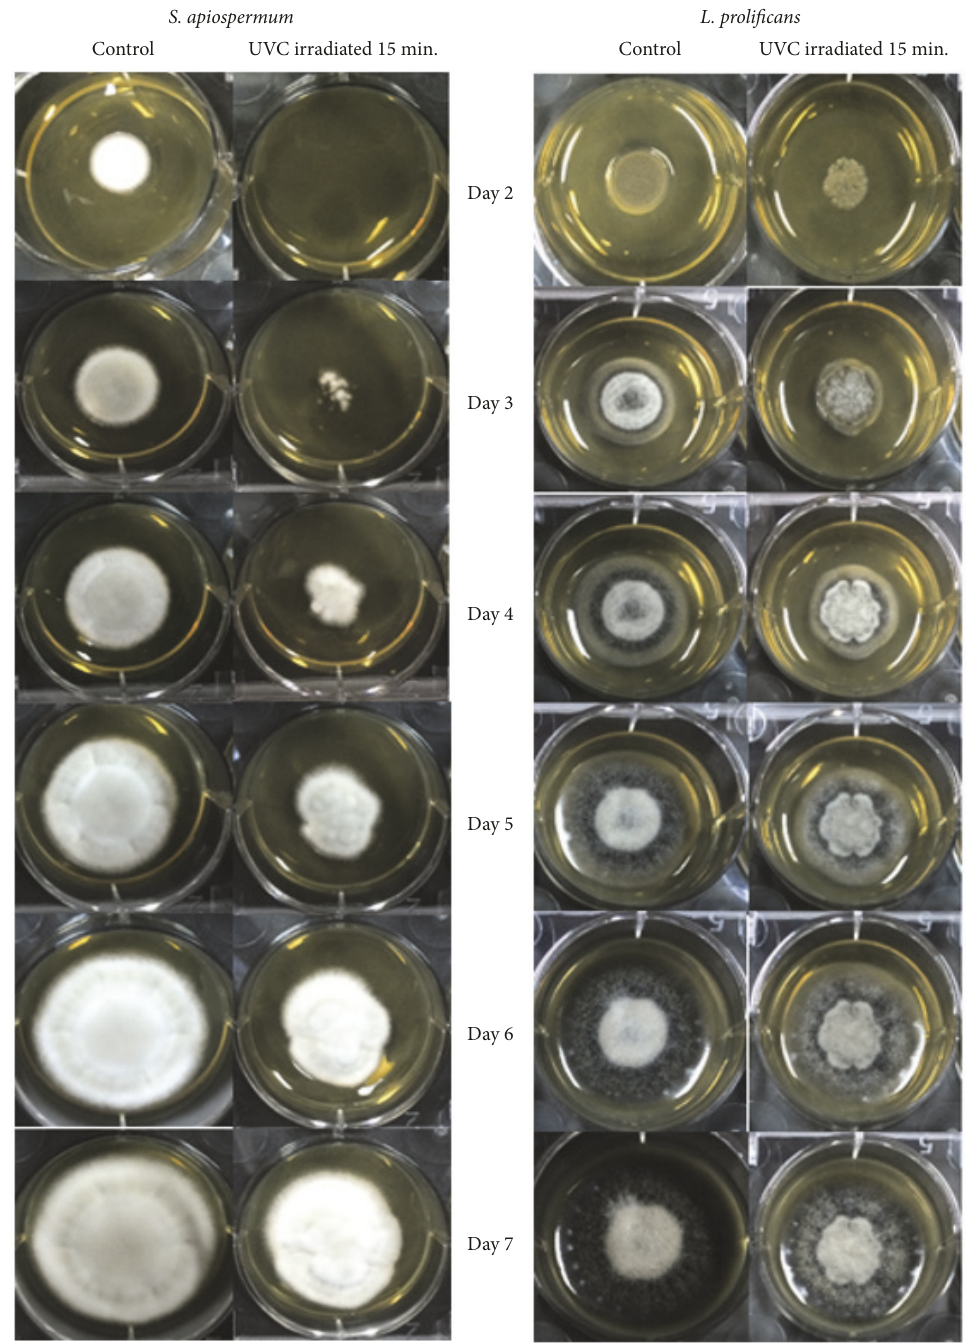
Figure 2: Colonies of S. apiospermum CBS 117410 and L. prolificans CM324 on SDA after 15 min of UVC exposure from days 2 to 7.